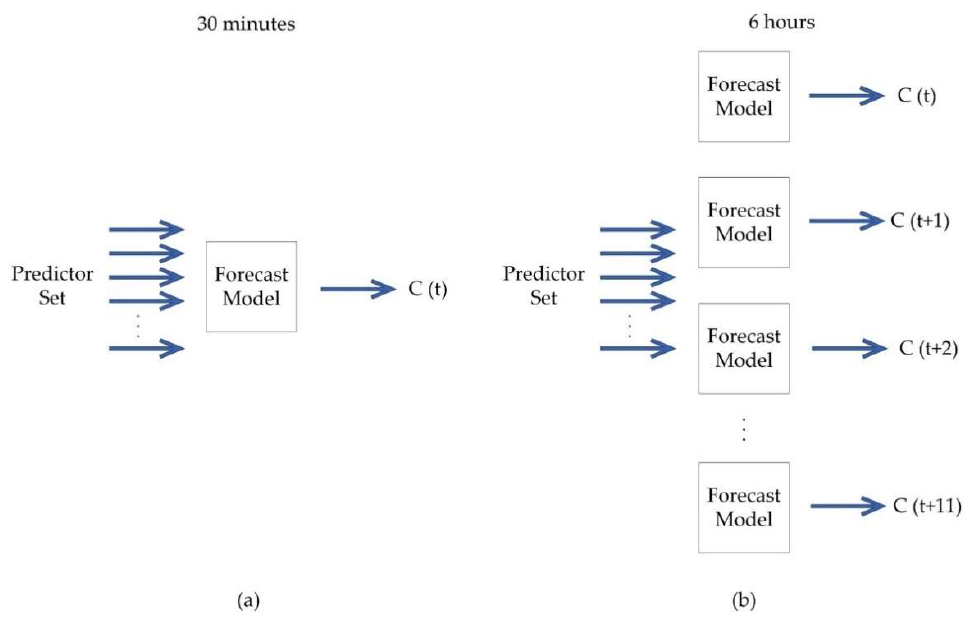
Figure 3. Predictive models for SVR and ARTMAP-Fuzzy network with a horizon of ( a ) 30 min and ( b ) 6 h.